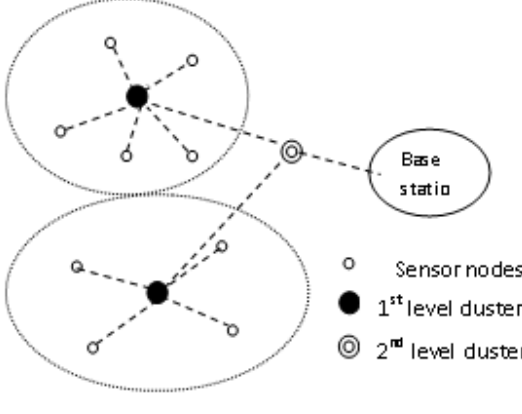
Figure 3. Hierarchical clustering in TEEN and APTEEN